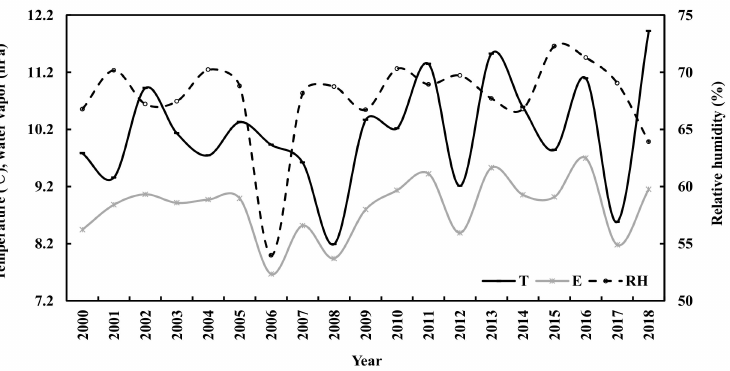
Figure 11. Annual air temperature (T), relative humidity (RH) and water vapor pressure (E) in April–September at Sodankylä.